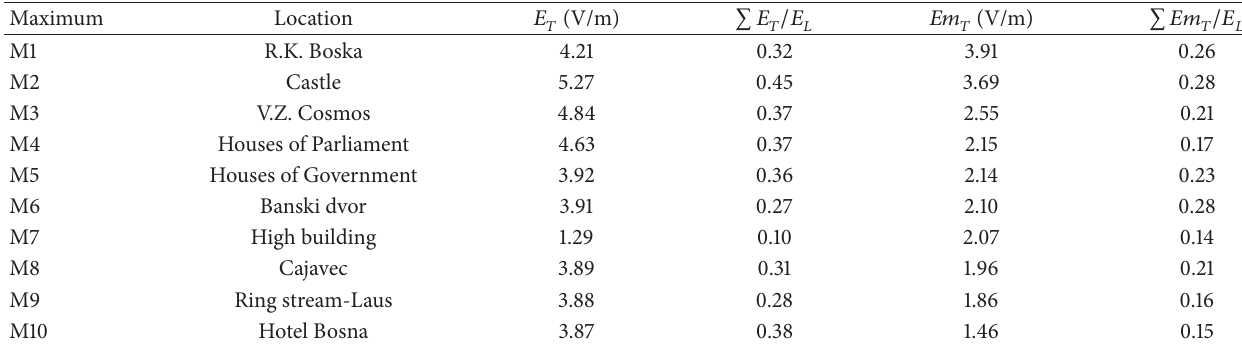
Table 5: Locations of points with maximum values of total composite electric field